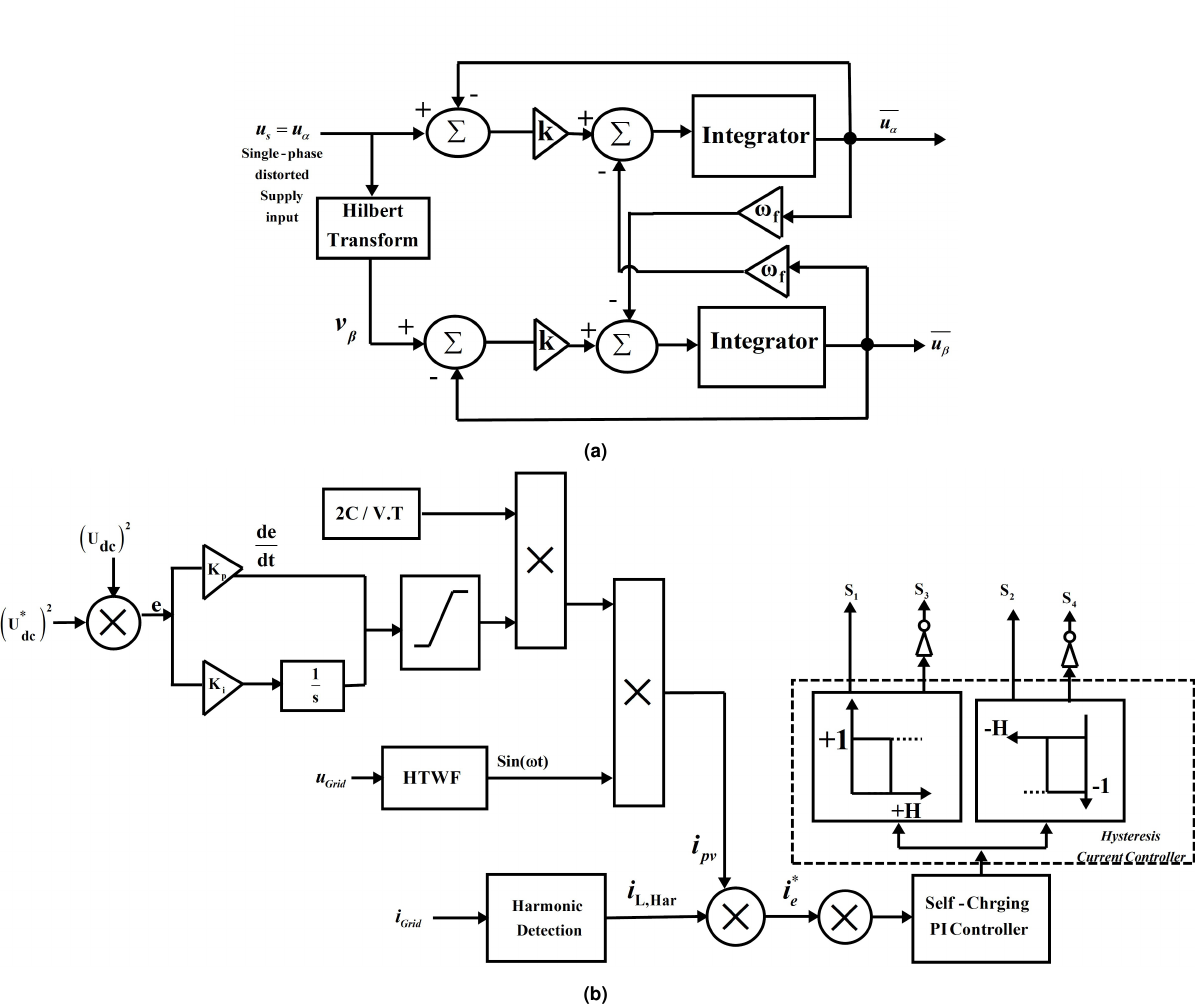
Fig. 2. Block diagram of HTWF based control algorithm (a) HTWF block (b) complete control scheme for grid connected PV